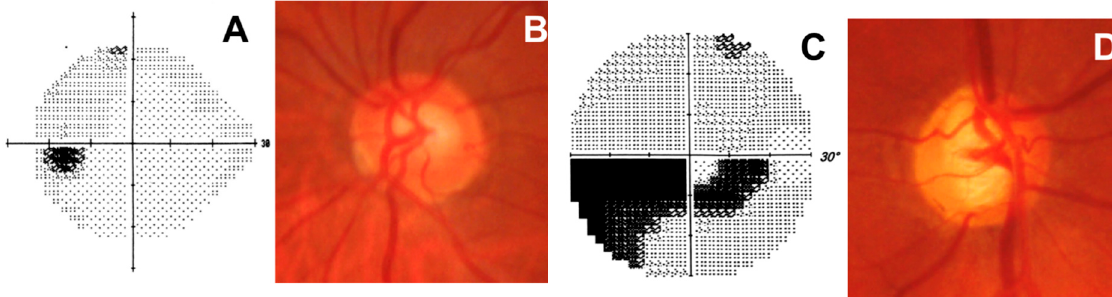
Figure 4. Normal optic nerve (left eye). ( A ) Normal visual field represented by the grayscale map. Darker areas indicate lower sensitivities, while higher sensitivities are represented by a lighter tone.